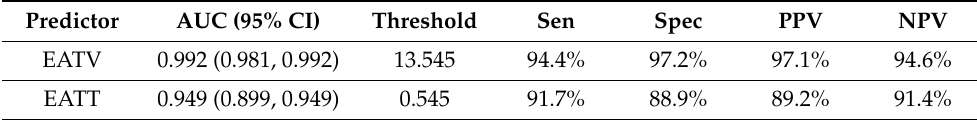
Table 3. Predictors of